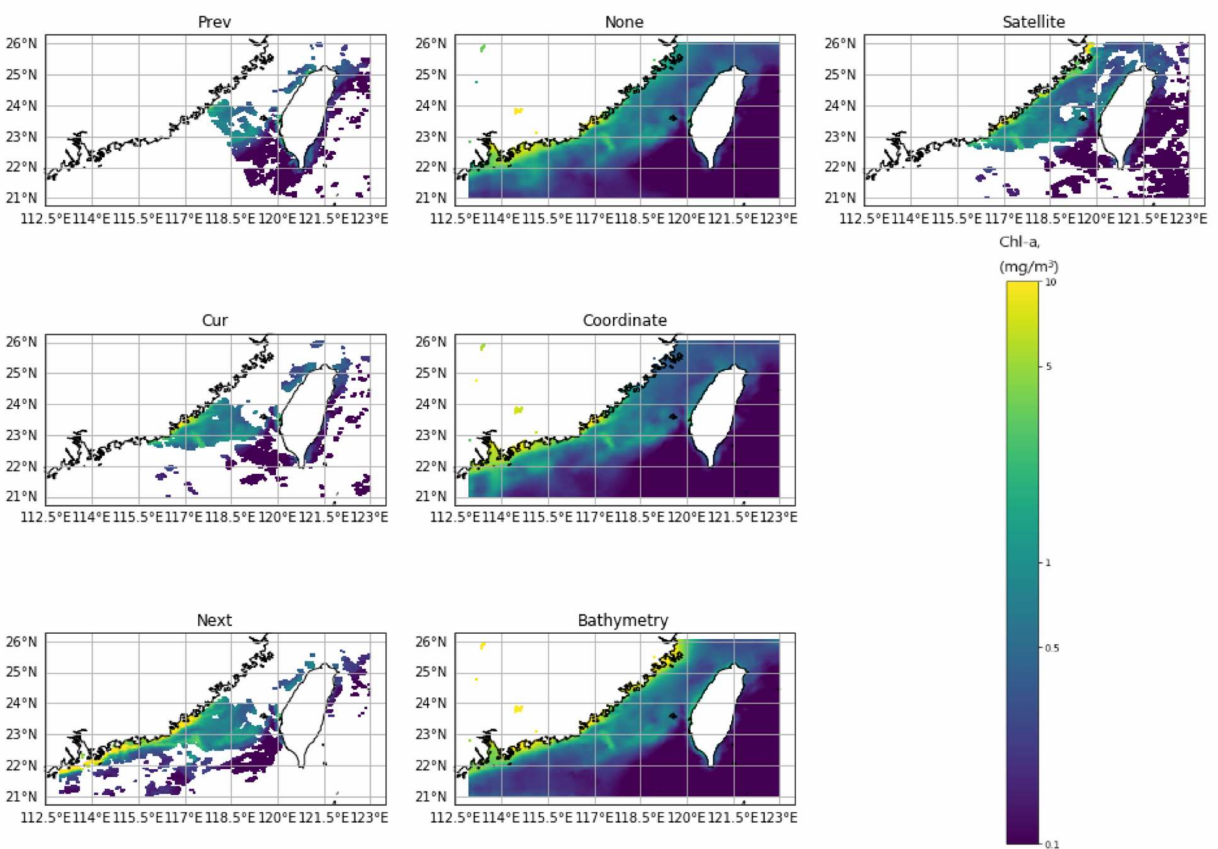
Figure 12. The reconstruction result of each model on a specific day for area2 which is not used in